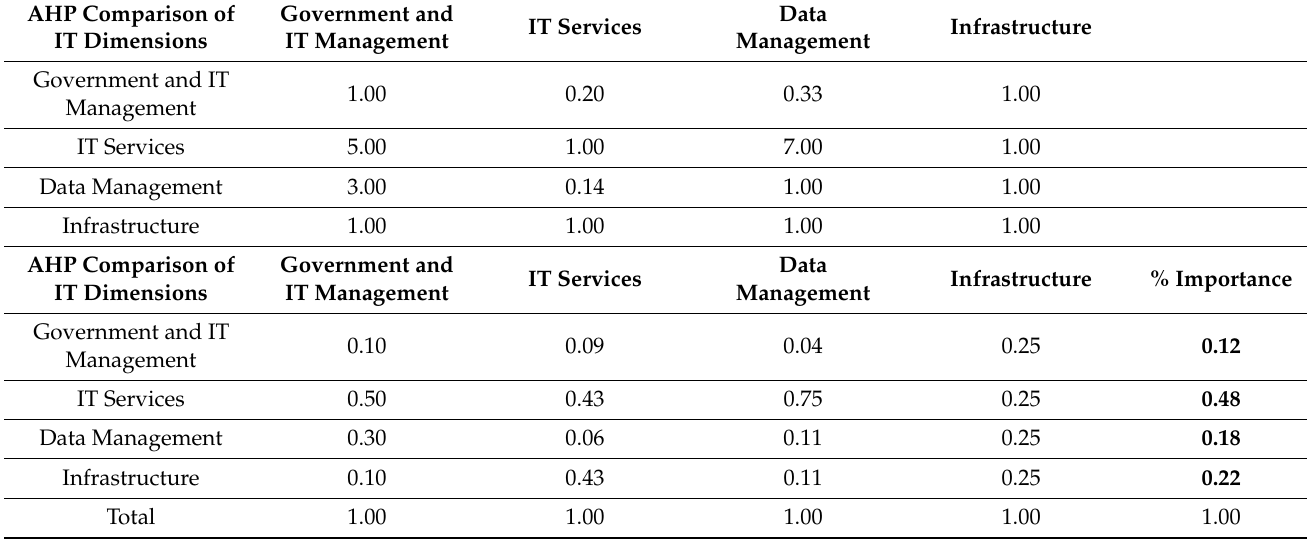
Table 9. Step 2b: Apply AHP to determine %